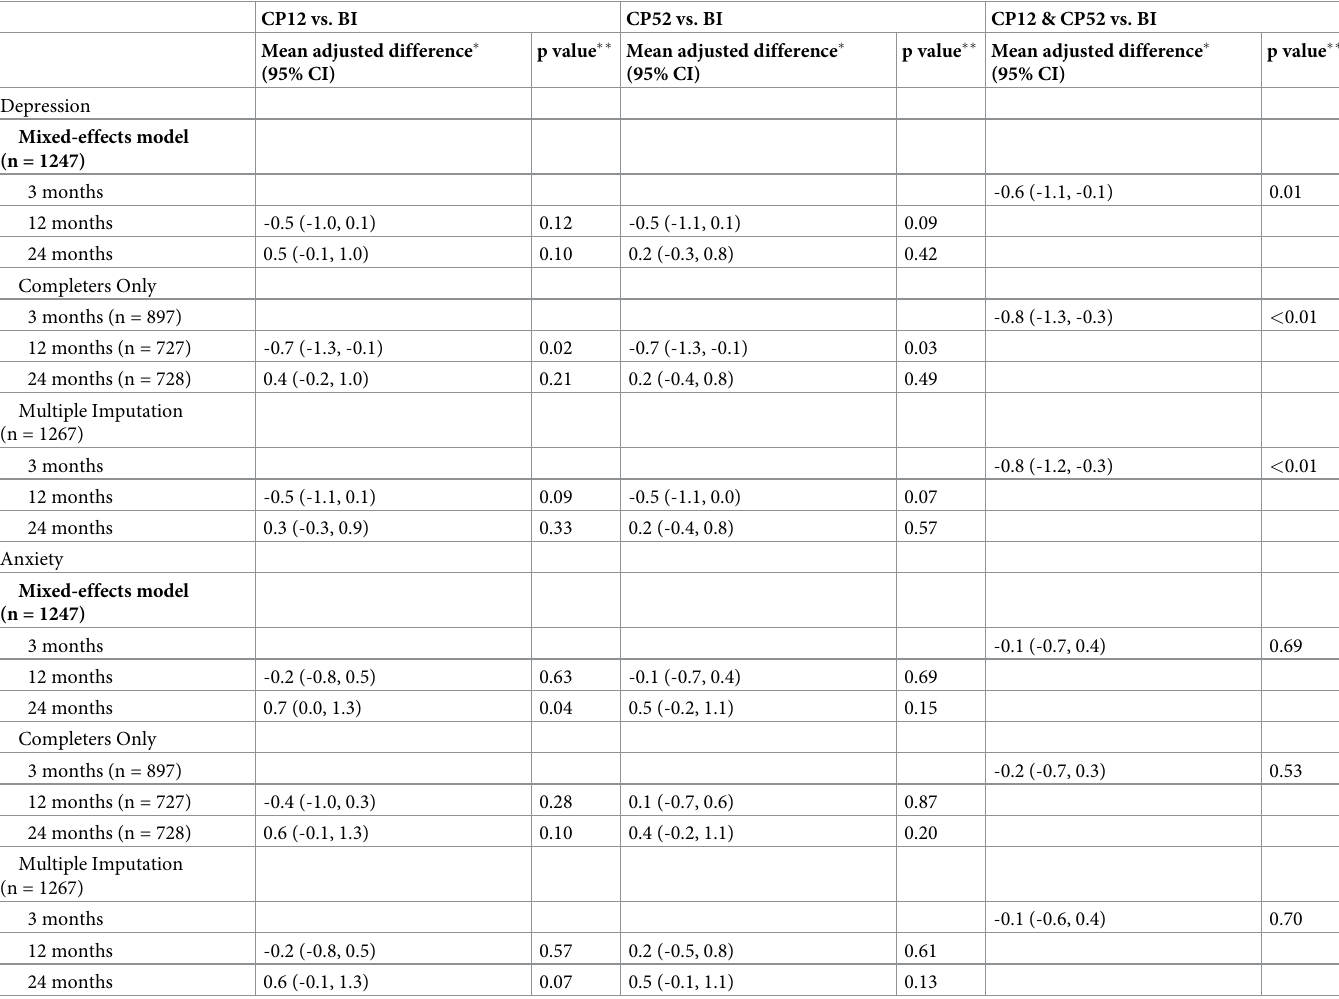
Table 3. Change in anxiety and depression score during a 12-week commercial provider (CP12) and 52-week commercial provider (CP52) weight loss programme compared to brief intervention (BI). CP12 vs.